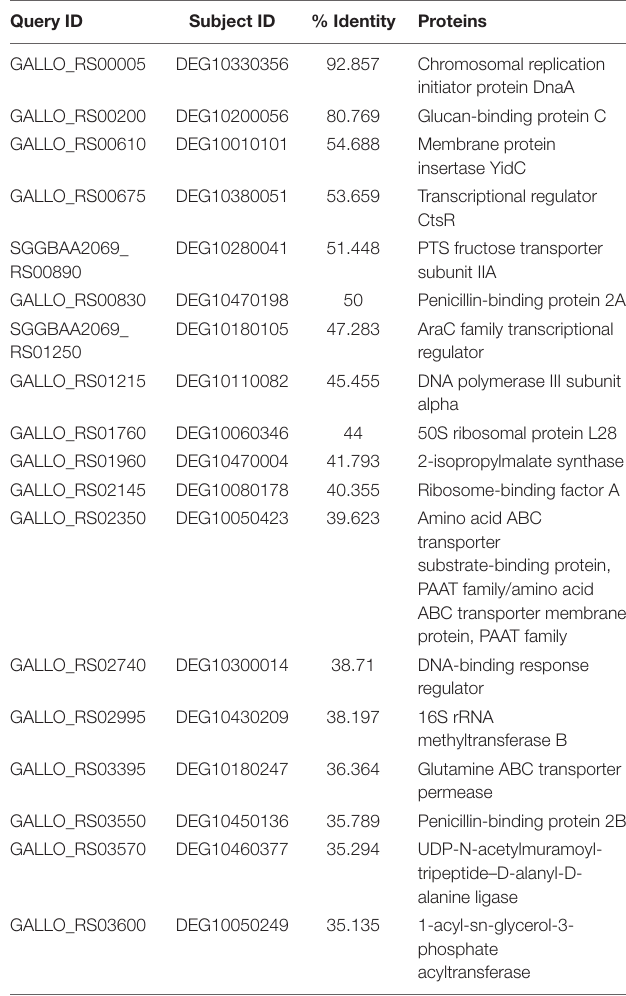
TABLE 2 | List of pathogen-essential non-host homologs